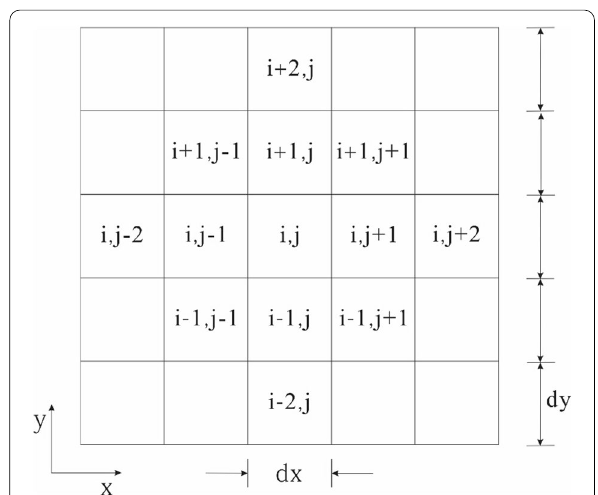
Fig. 13 Schematic diagram of the central difference grid